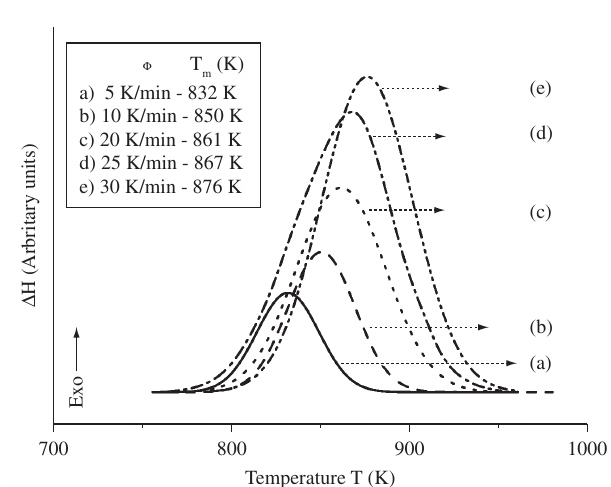
O . Figure 3. DSC curves related to the α -BZN crystallization. 2 3